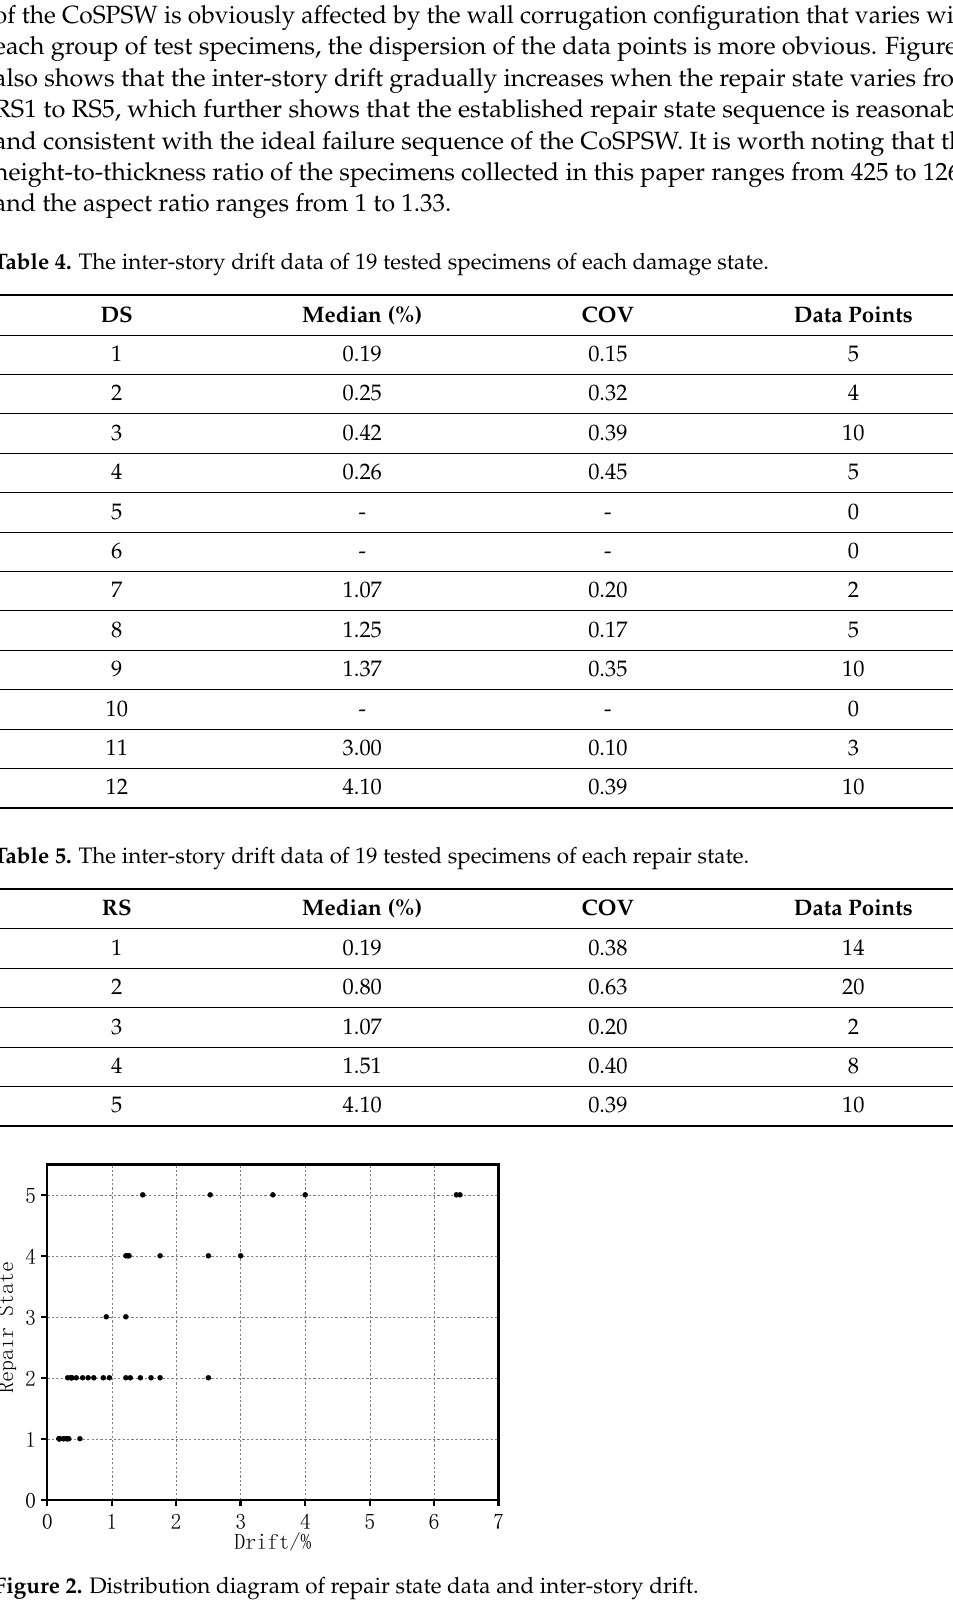
Table 4. The inter-story drift data of 19 tested specimens of each damage state.